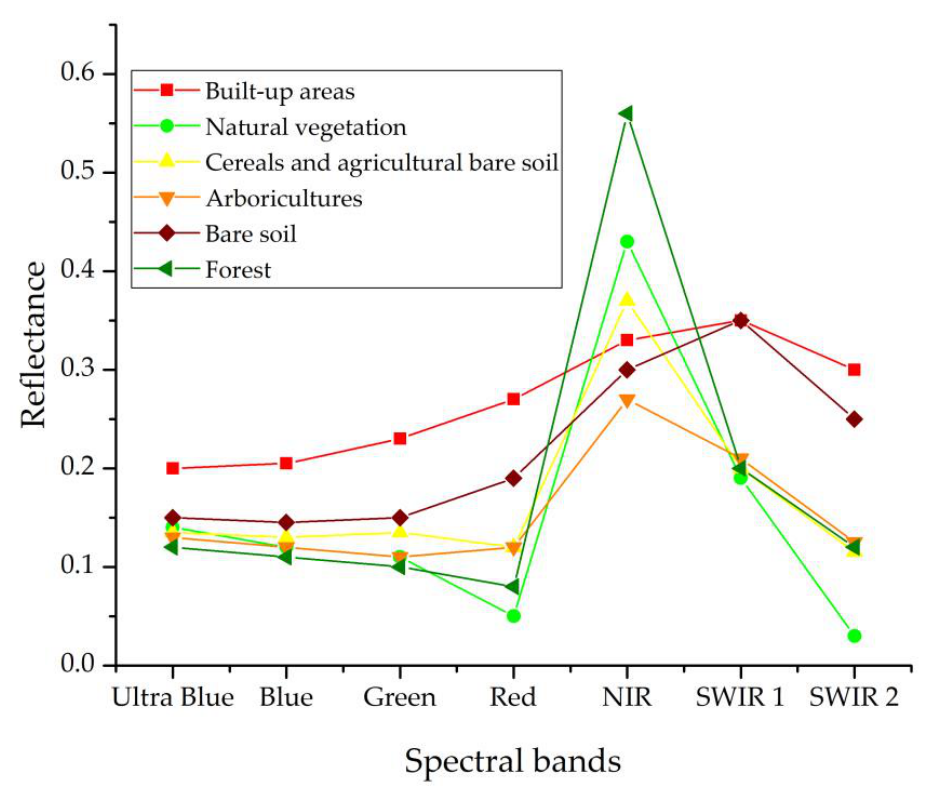
Figure 5. Spectral profiles of different classes.